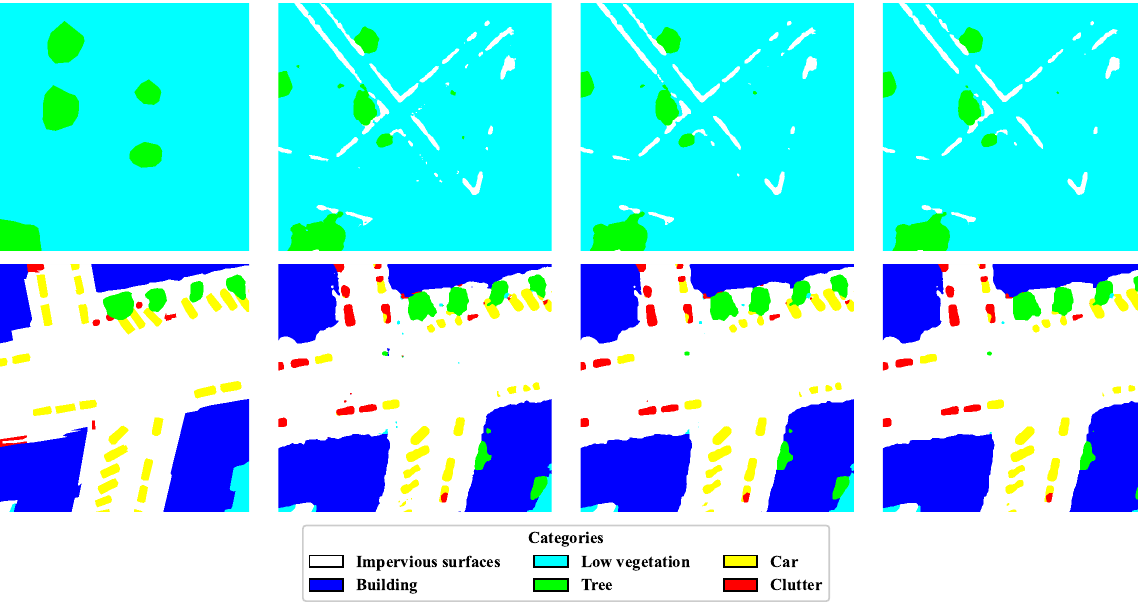
Figure 2. Image details of semantic segmentation. From left to right: ground truth, U-Net segmentation, MRF400 optimization, MRF800